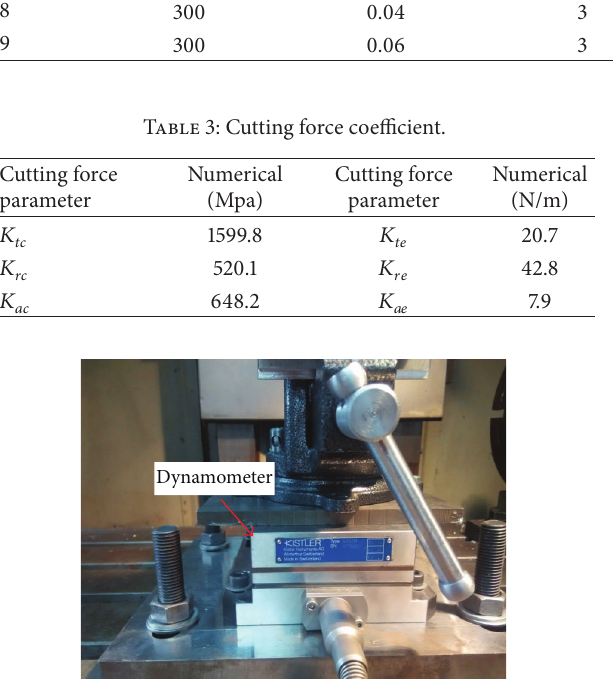
Figure 9: Kistler 9257B dynamometer.